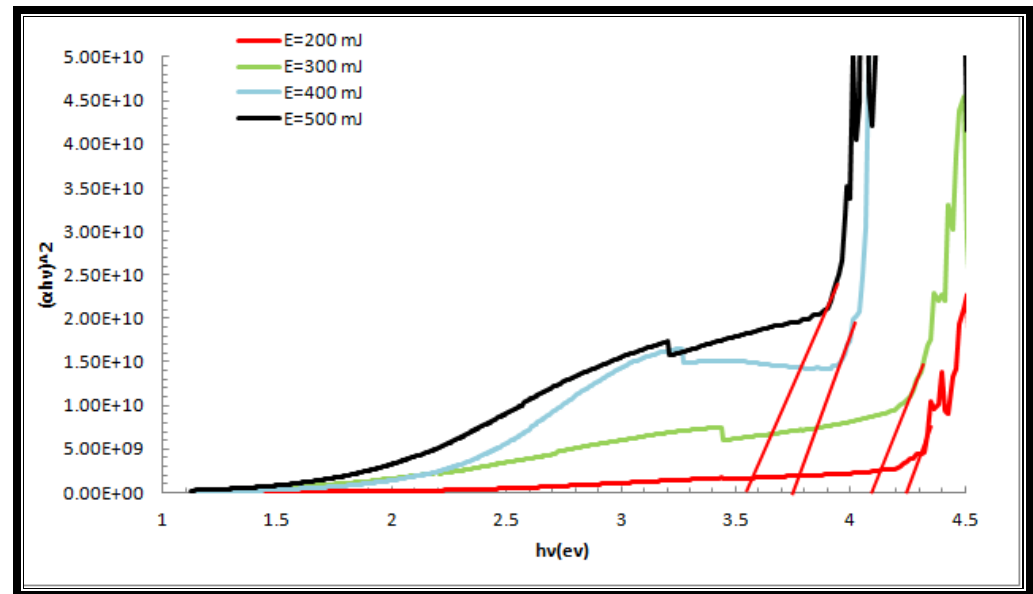
Fig. 8: The variation of (αhυ) 2 versus photon energy (hυ) for CdO:CoO films with different laser energy. Table 3: The energy gap values for CdO:CoO thin